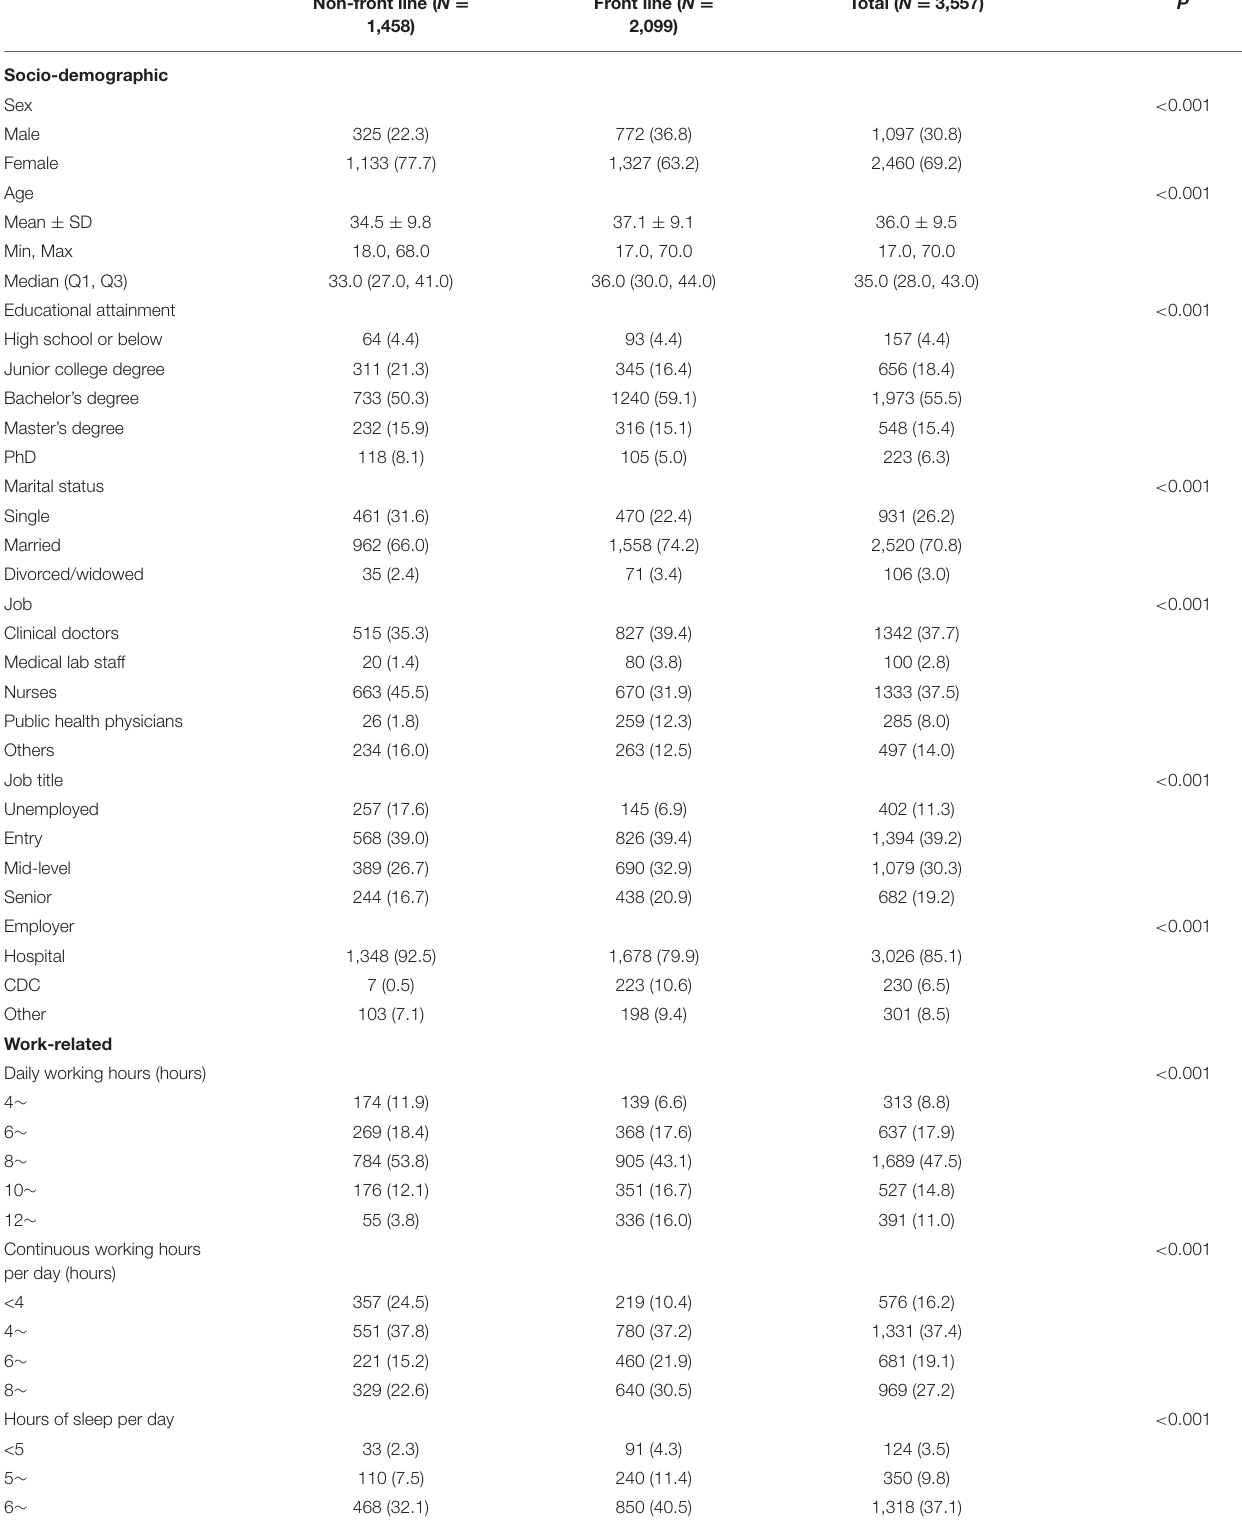
TABLE 1 | Participants’ socio-demographic factors, work-related factors, social support, mental health, insomnia and fatigue ( N %).